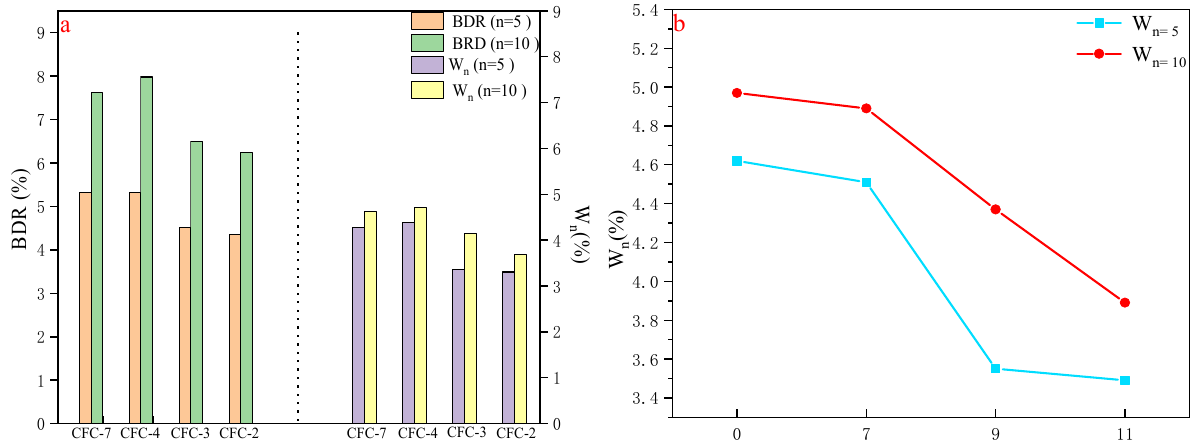
Figure 7. Freeze–thaw cycle test results ( a ) comparison of freeze–thaw loss rates, ( b ) mass loss rates after n freeze–thaws for different CSS.